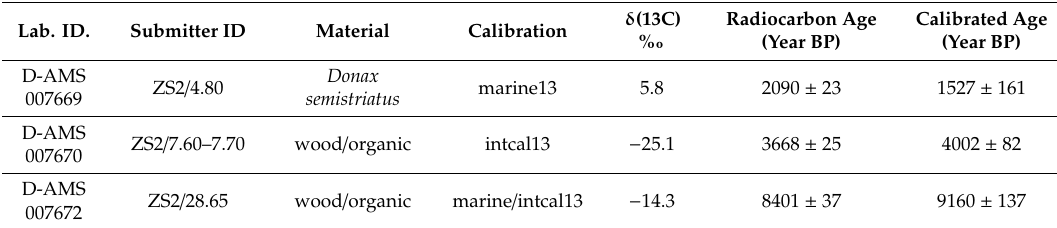
Table 1. Samples dated with the 14C method coming from ZS2 borehole. For the location of the samples in the core, see Figure